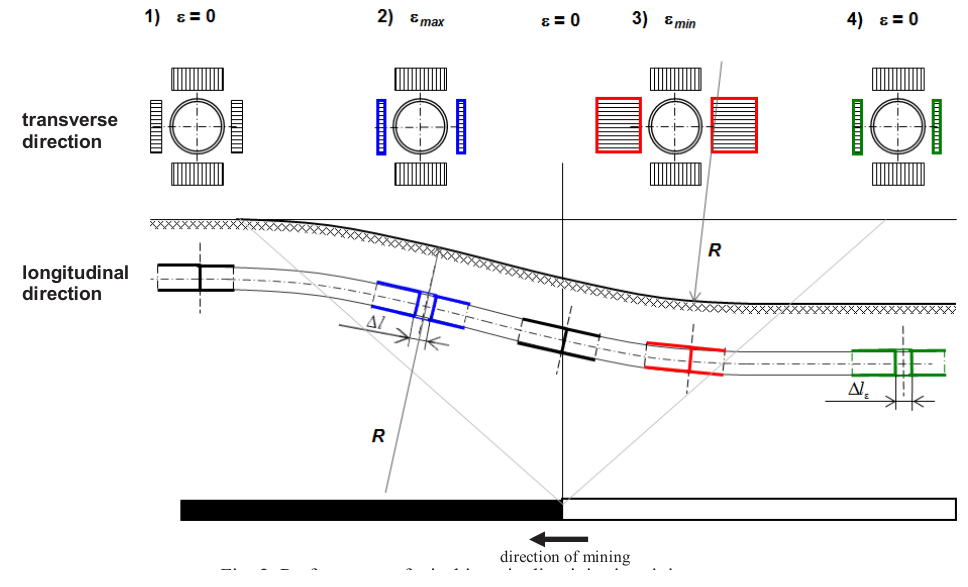
Fig. 2. Performance of a jacking pipeline joint in mining areas Figure 2: Performance of a jacking pipeline joint in mining